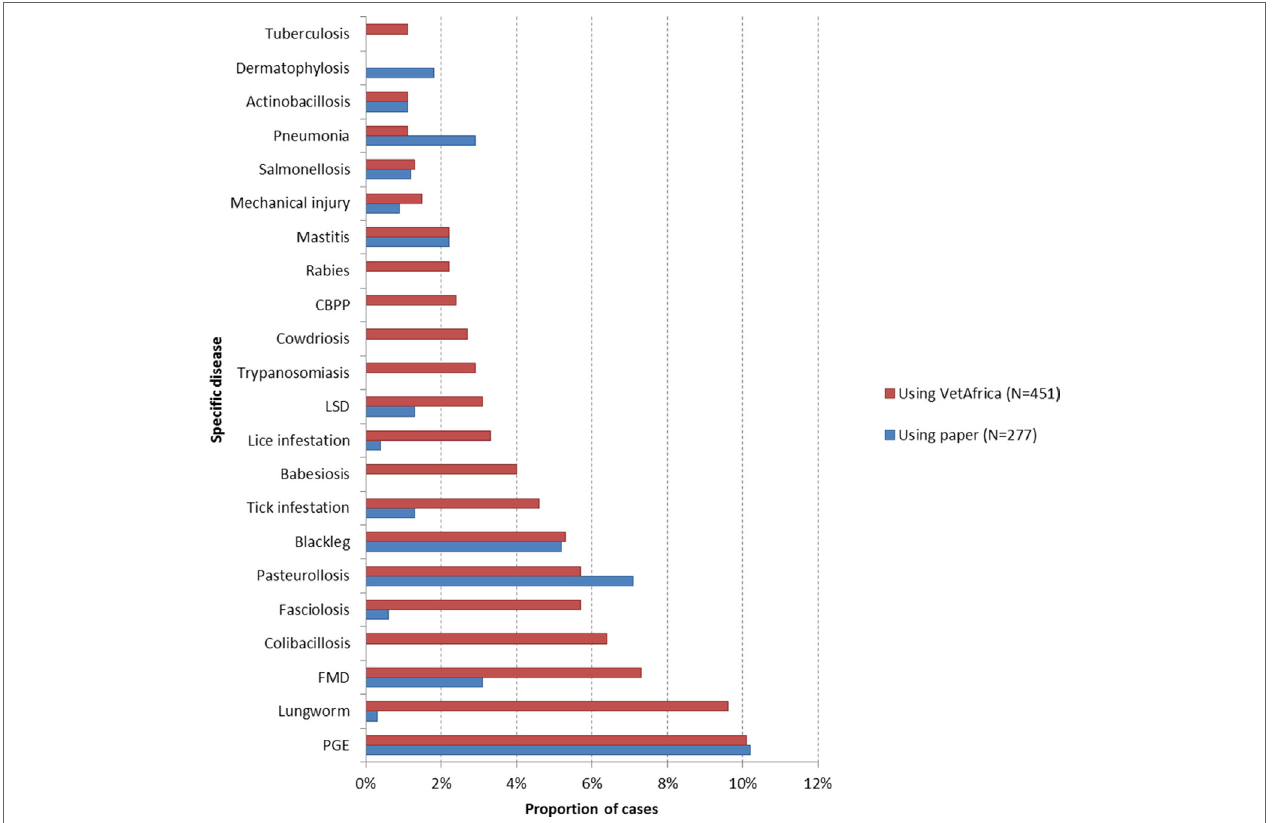
FigUre 1 | Comparison between the leading putative causes of cattle morbidity where specific disease was reported in cases using VetAfrica–Ethiopia ( N = 451) and those using traditional paper-based reporting ( N = 277). Abbreviations: PGE, parasitic gastro enteritis; FMD, foot and mouth disease; LSD, lumpy skin disease; CBPP, contagious bovine